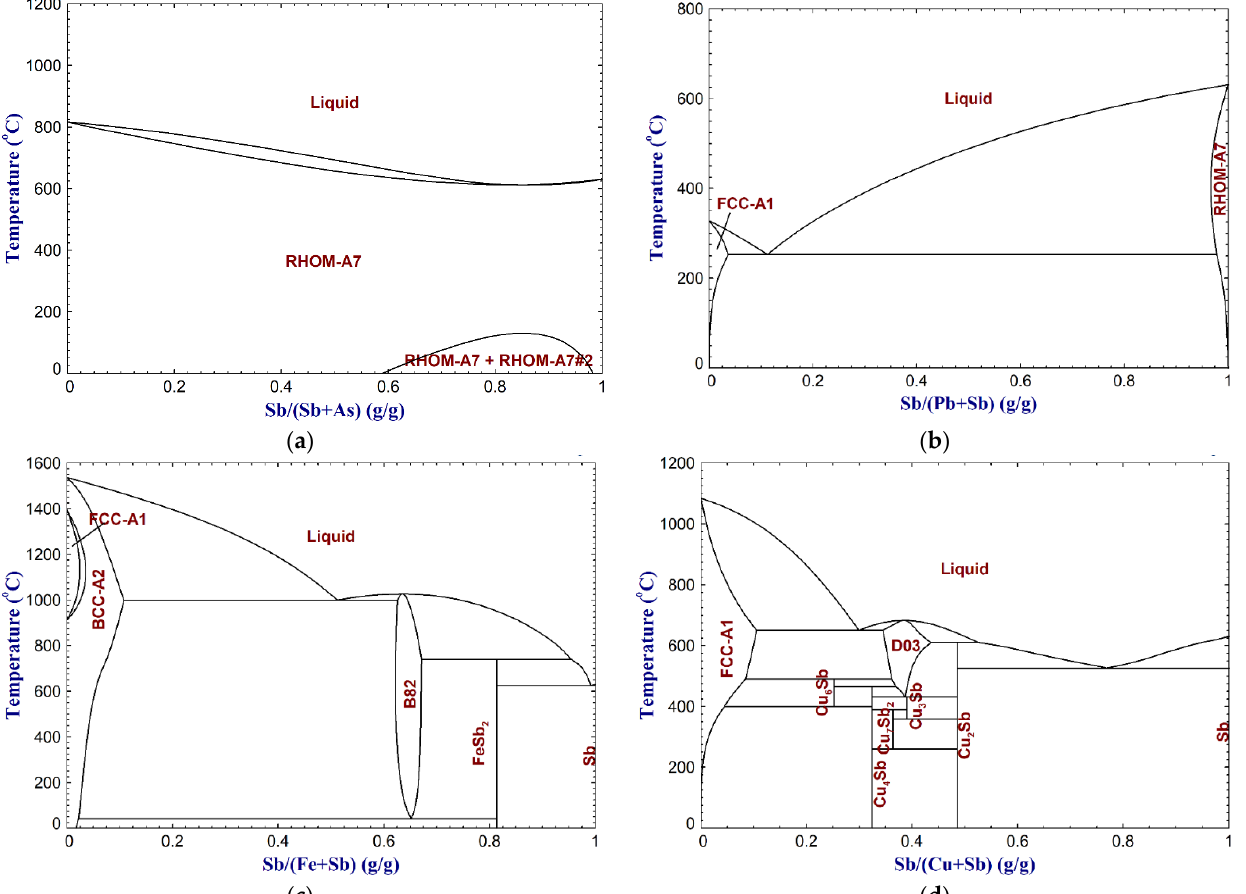
Figure 16. Binary phase diagrams; ( a ) As-Sb, ( b ) Pb-Sb, ( c ) Fe-Sb, and ( d ) Cu-Sb, calculated using FactSage 8.1 FTlite database [83].